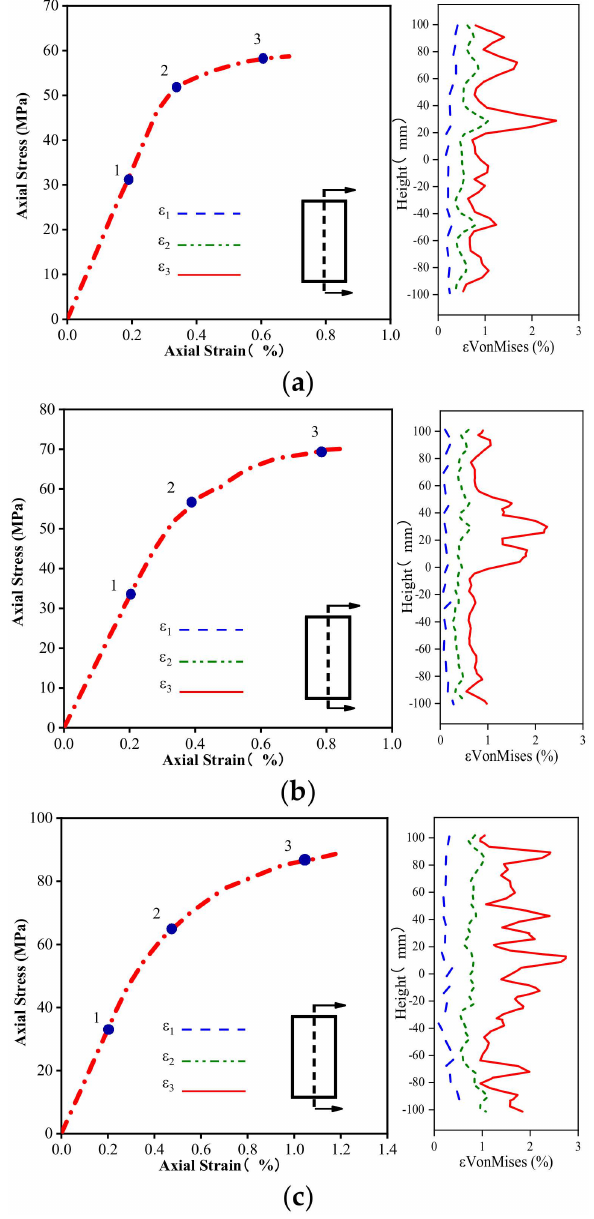
Figure 11. Comparing the Von Mises strain development of ( a ) E1, ( b ) E2, and ( c )